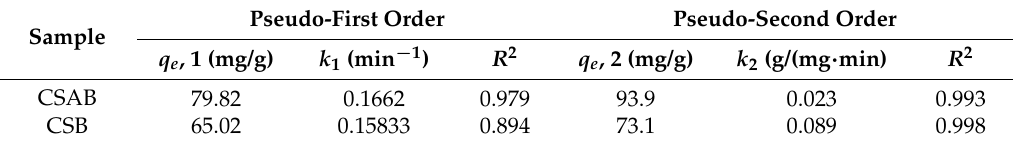
Figure 10. Pseudo second-order model for adsorption of diesel oil onto: ( a ) CSB; ( b ) CSAB. Table 2. Comparison of the pseudo-first order and pseudo-second order models for the adsorption of diesel oil on crab shell biochar.